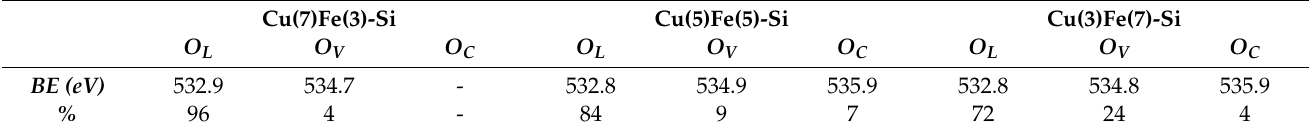
Table 4. Relative concentration of oxygen species calculated from the O 1s peak